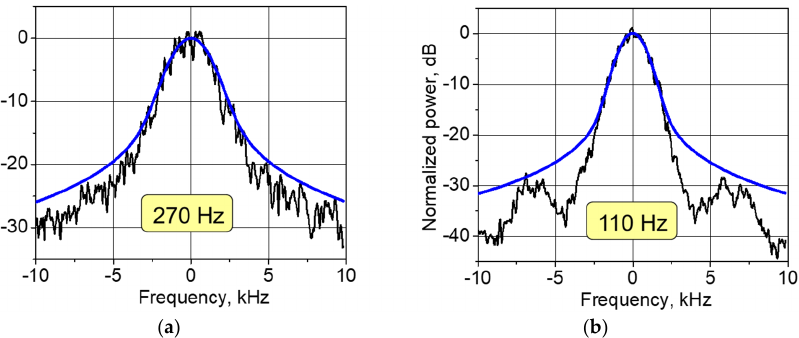
Figure A5. The self-heterodyne spectra of the pump ( a ) and Stokes ( b ) laser radiation: the measured spectra (black) and their fitting by the Voigt functions (blue). The fitting parameters evaluating the Gaussian and Lorentzian contributions are w G = 2.2 kHz , w L = 540 Hz and w G = 1.7 kHz , w L = 220 Hz , for the pump and Stokes outputs, respectively.